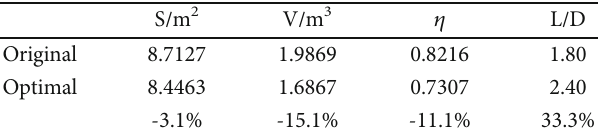
Figure 10: History of iteration. Table 2: Di ff erence in properties between the optimized and original con fi